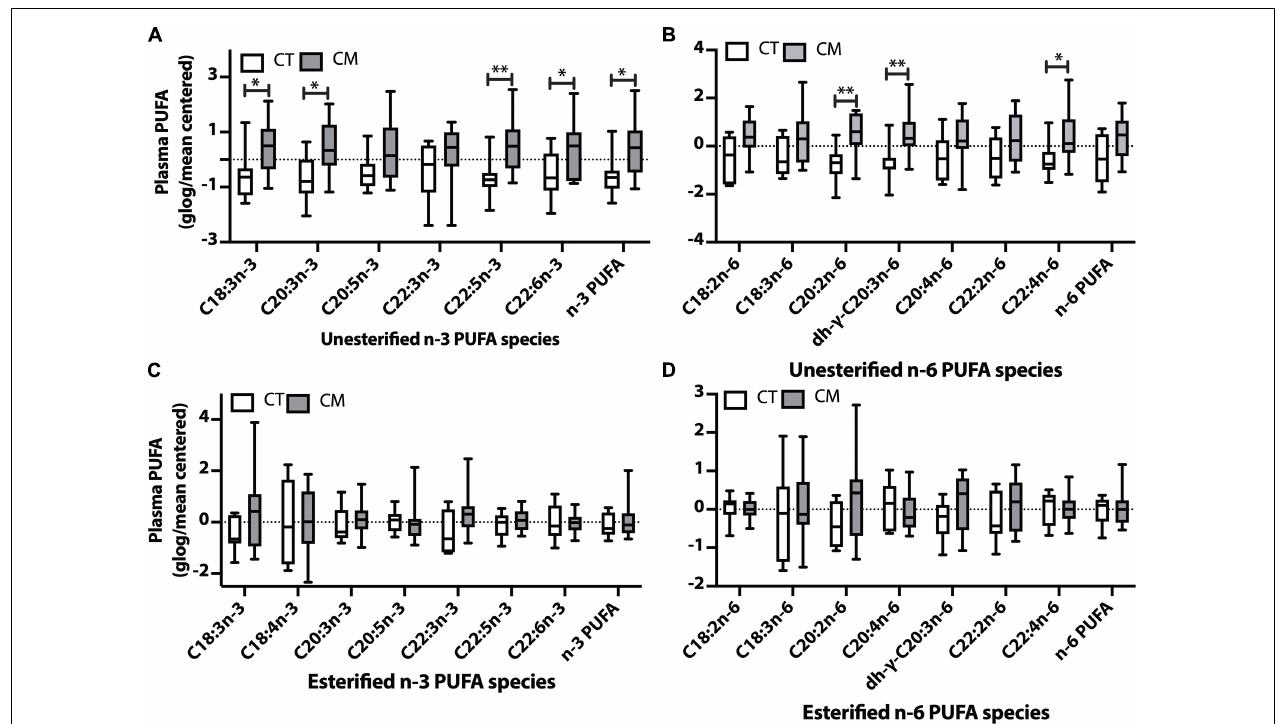
FIGURE 4 | Polyunsaturated fatty acid (PUFA) changes in plasma of CT versus CM. Box and Whisker plots of unesterified n-3 PUFAs (A) , unesterified n-6 PUFAs (B) , esterified n-3 PUFAs (C) , and esterified n-6 PUFAs (D) . PUFA levels (ng/mL) were normalized using globalized logarithmic transformation and mean-centered. Unpaired multiple t -tests with correction for multiple comparisons (False Discovery Rate, FDR) used the two-state step-up method of Benjamini, Krieger, and Yekutieli. ∗ denote adjusted p ( q ) < 0.05, ∗∗ p < 0.01.